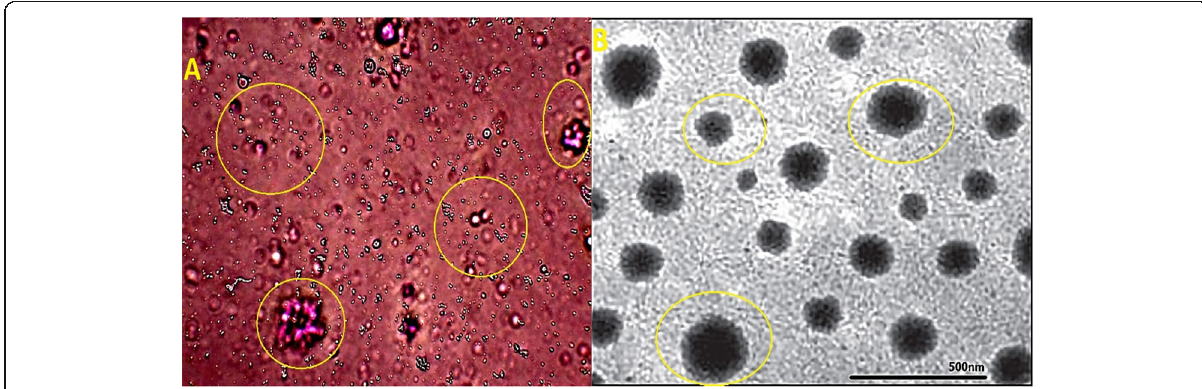
Fig. 1 a The yellow circles indicating the formation of ufasomes in the slide. b Transmission electron microscopy (TEM) image of glyceryl oleate ufasomes of terbinafine hydrochloride at 80 kV and ×